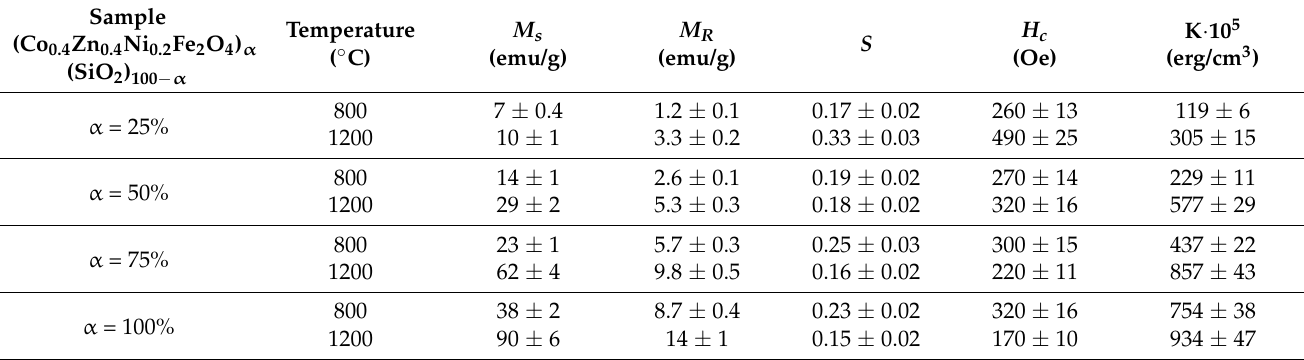
Table 2. Saturation magnetization ( M S ), remanent magnetization ( M R ), coercivity ( H c ) and